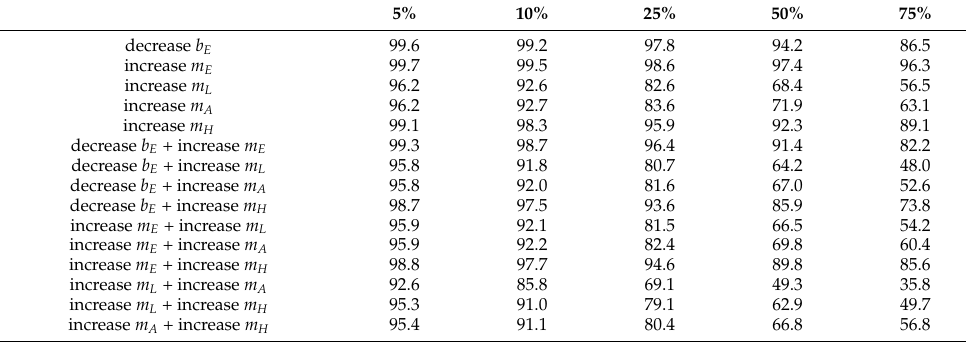
Table 3. Effect of mosquito control strategies, increasing/decreasing different vital rates by a certain percentage, on the relative population size. The percentage of active mosquitoes during the study period (1991–2010) was obtained by using the altered rate in relation to the number of mosquitoes predicted by the model after